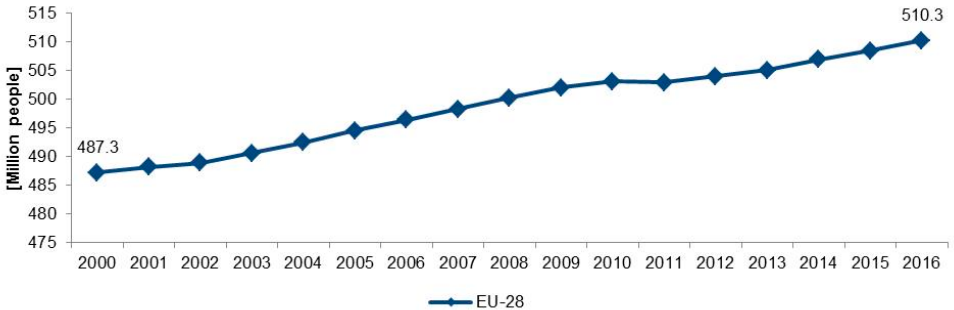
Figure 4. Population in the EU-28, 2000–2016. Source: Eurostat.